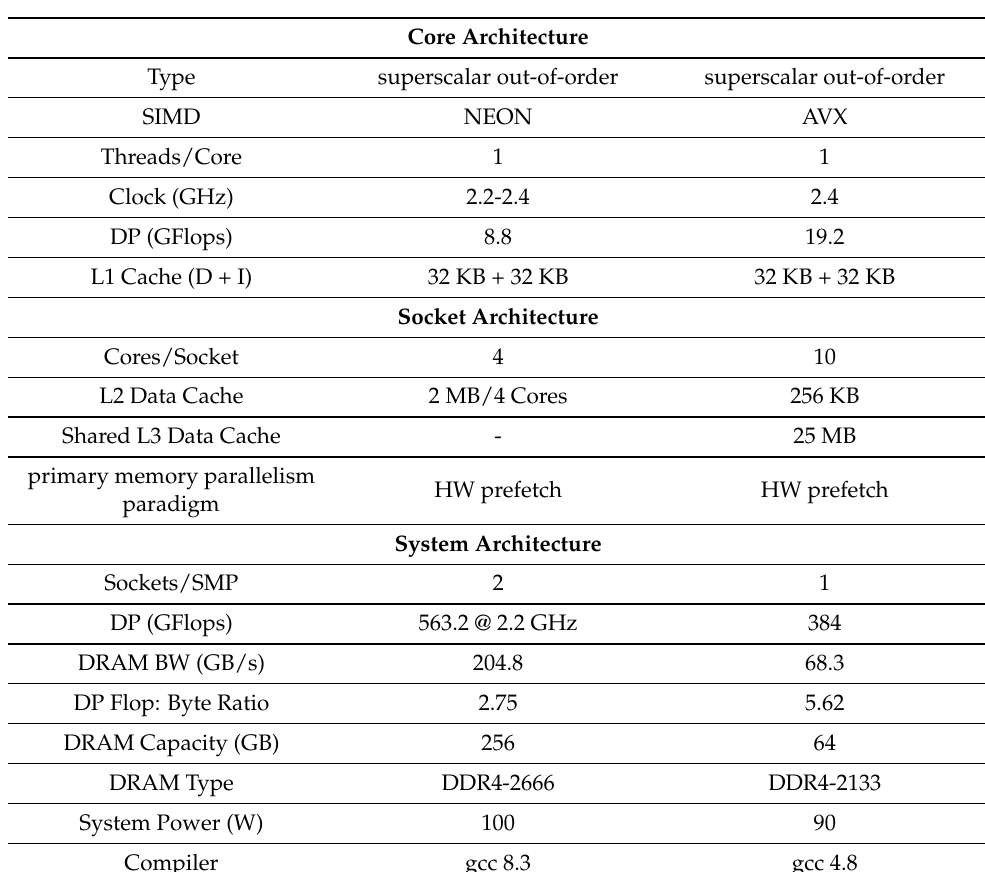
Table 2. Architectural summary of experimental